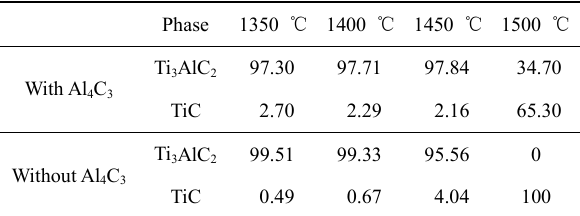
Estimated Ti 3 AlC 2 and TiC contents in samples sintered at different temperatures with or without Al 4 C 3 embedding